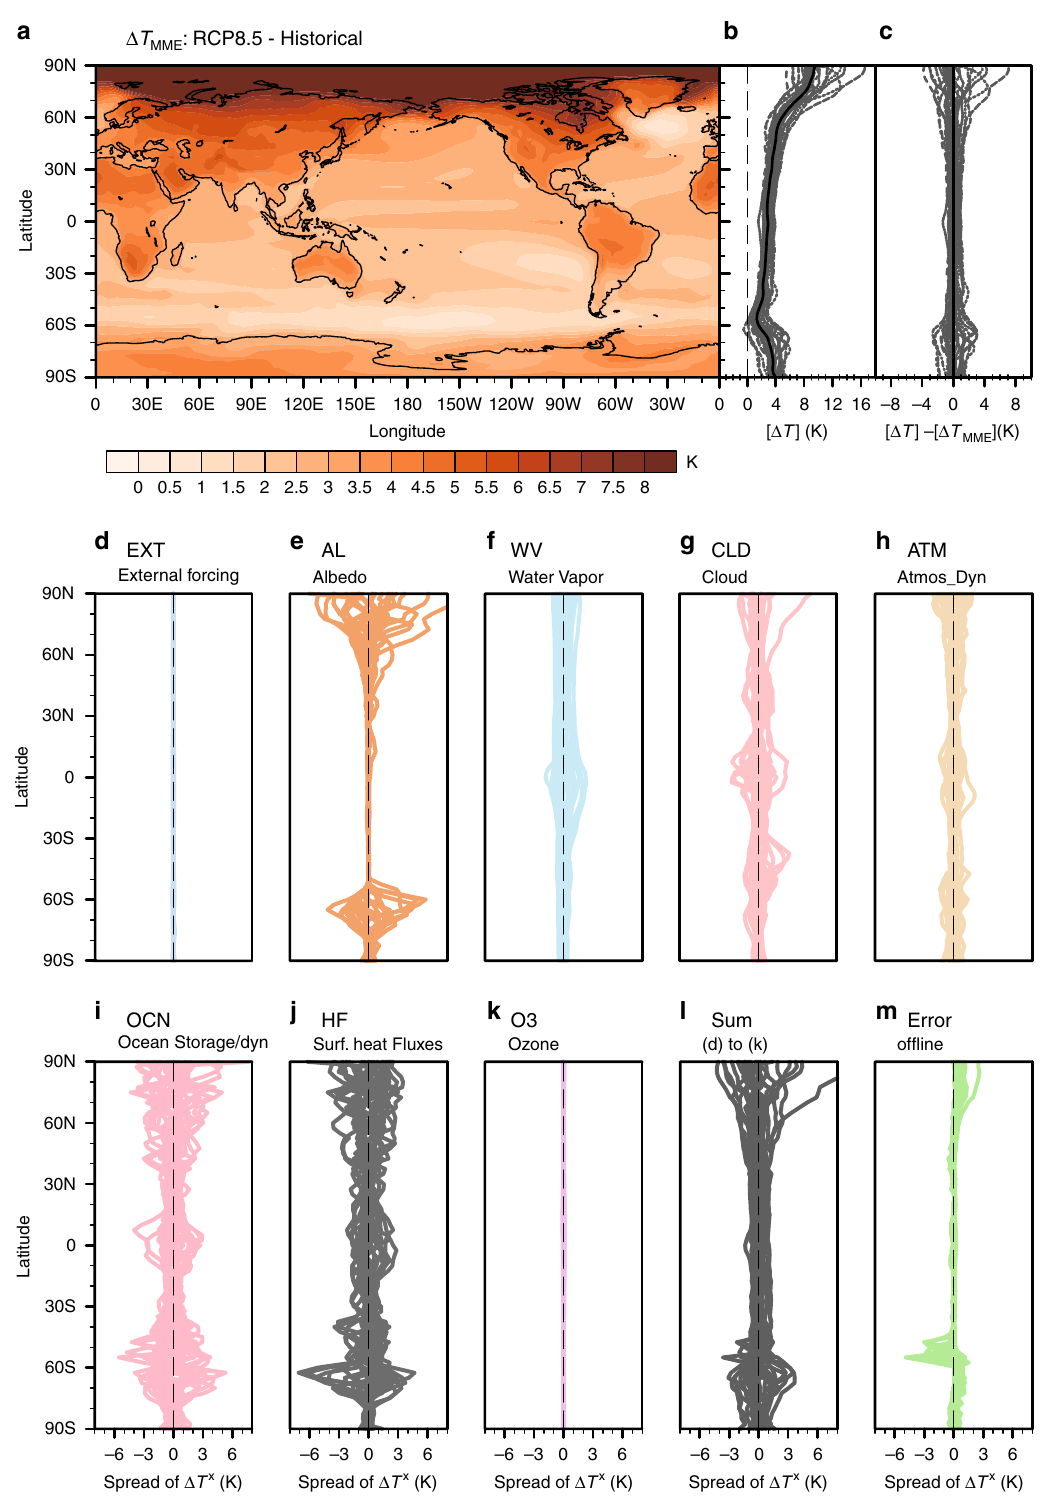
Fig. 1 Inter-model spread of surface warming. a Multi-model ensemble (MME) mean surface temperature changes ( K ) between the projected climate (2051 – 2100) of the RCP8.5 (Representative Concentration Pathway) simulations and the historical climate (1951 – 2000) derived from 25 models of the Coupled Model Intercomparison Project Version 5. b Zonal mean surface temperature change ( K ) for individual models (gray lines) and their MME mean (thick black line). c Same as b but with the MME removed. Inter-model surface warming spreads (with their respective MMEs removed) in the individual partial surface temperature changes ( K ) due to changes in d carbon dioxide (EXT), e surface albedo (AL), f water vapor (WV), g clouds (CLD), h atmospheric dynamics (ATM), i ocean dynamics plus heat storage (OCN), j surface turbulent heat fl uxes (HF), and k ozone (O3). l The sum of d – k and m is the difference between l and c , corresponding to the error of the CFRAM analysis. The square bracket [] in the abscissa labels of b and c represents the zonal average of the surface warming whereas the superscript X in the abscissa labels of d – m denotes the zonal average of the partial temperature changes associated with processes whose names are given on the top of the